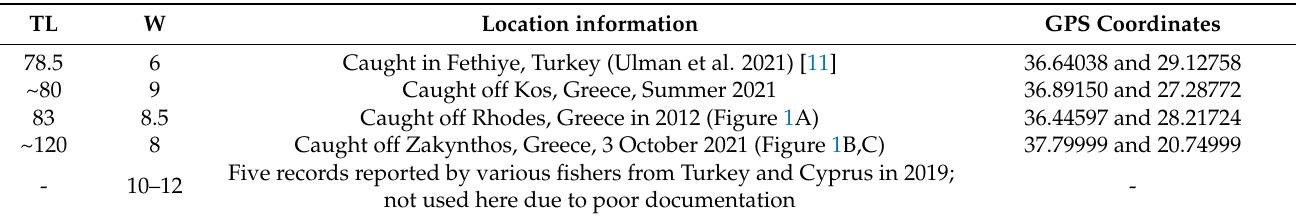
Figure 1. Evidence for large specimens of Lagocephalus sceleratus . ( A ) 8.5 kg specimen caught off Rhodes, Greece in 2012; ( B ) 8 kg specimen caught on October 3rd 2021 in Zakynthos, Greece; ( C ) The same specimen, with fisher Christos Pastras (178 cm). Table 1. Lengths and weights of large specimens of silver ‐ cheeked toadfish, Lagocephalus sceleratus in the Eastern Mediterranean. TL = total length (cm); W = live weight (in kg).